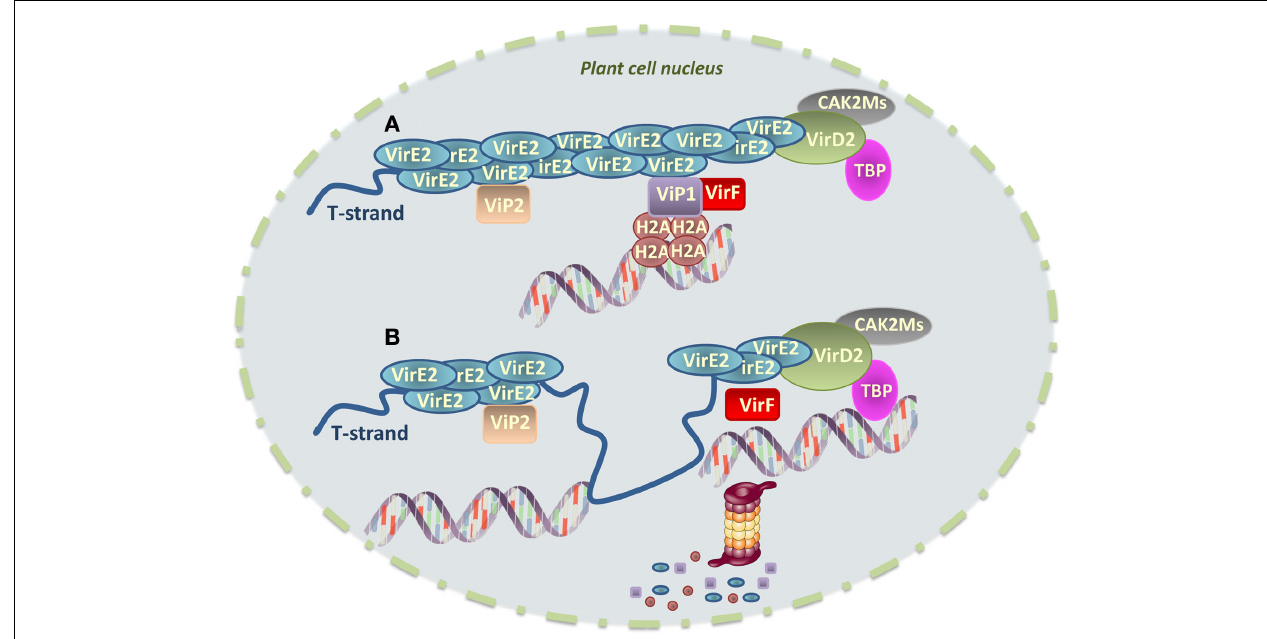
andTBP are also represented.VirF interacts withVIP1 attached to both nucleosomes and theT-complex. (B) Before integration,VirF helps uncoat the T-strand promoting proteasomal degradation ofVIP1,VirE2 and, very likely, VIP1-interacting core histones.This creates a chromatin environment favorable forT-DNA integration.Whether synthesis of the second-strand occurs before or after association of theT-strand with the chromatin remains unknown. It is possible that second-strand synthesis and integration represent coupled